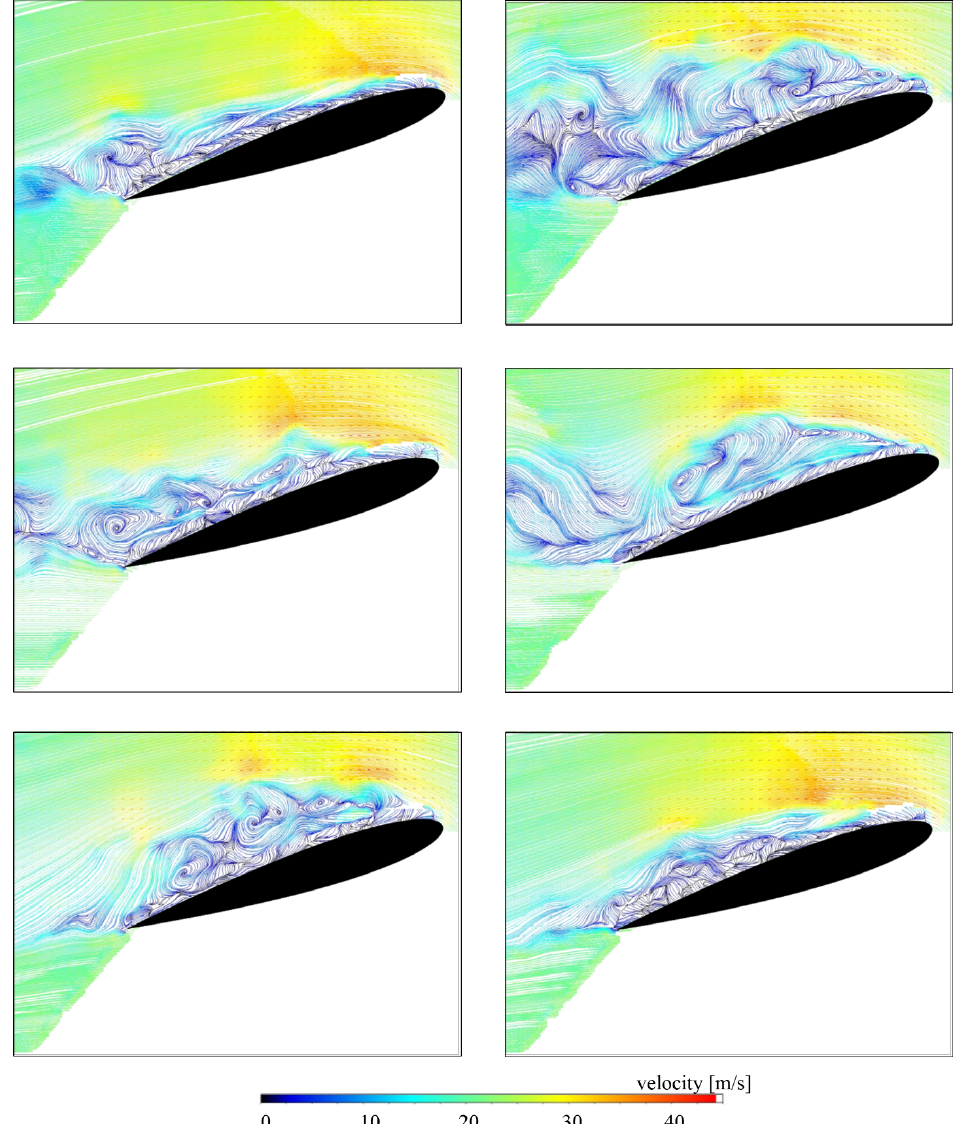
Figure 24. Evolution of different instantaneous flow structures and vortices with plasma actuation at F + c = 1 and Re = 100,000 (constant flow